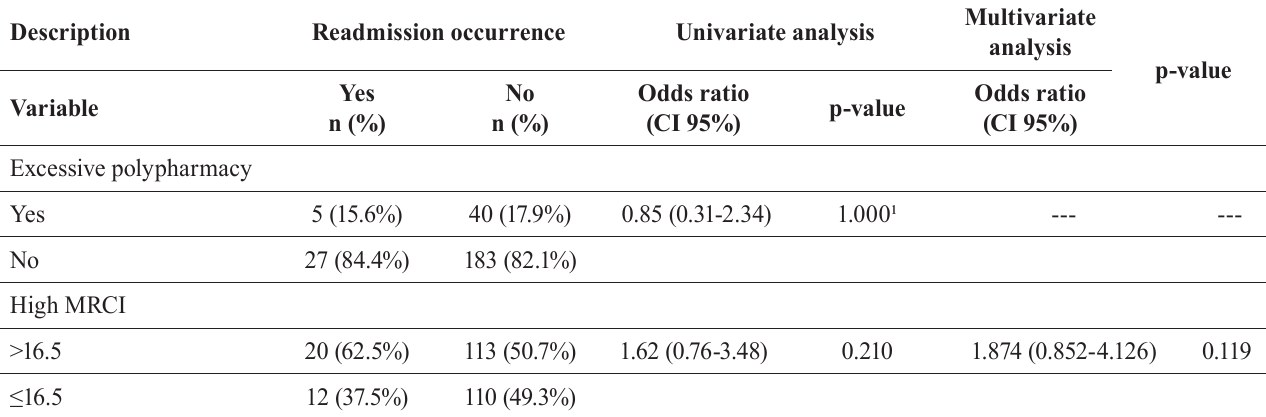
TABLE II – Univariate and multivariate analysis of the factors associated with the occurrence of readmission of older adults